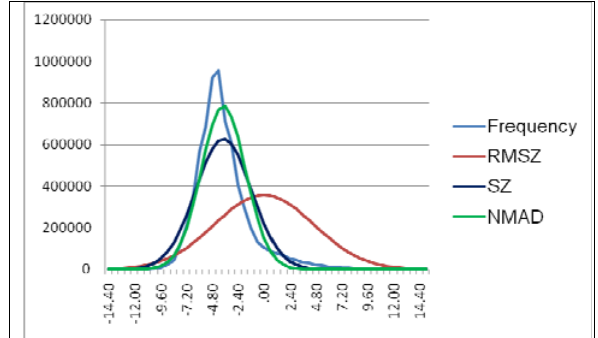
Figure 1: frequency distribution of discrepancies of SRTM DSM against reference DEM in open areas and normal distribution based on RMSZ, SZ and NMAD, test area Warsaw Figure 1 demonstrates the situation of different accuracy figures at the example of the SRTM height model in test area Warsaw, limited to the open area – without forest, but with small tree groups and limited number of buildings. The frequency distribution has a bias of -3.76m which influences the root mean square error. The standard deviation is related to the bias as well as NMAD. As the overlaid normal distribution based on SZ and NMAD show, more large height discrepancies are included as corresponding to normal distribution, influencing the value of SZ stronger as the linear NMAD. The